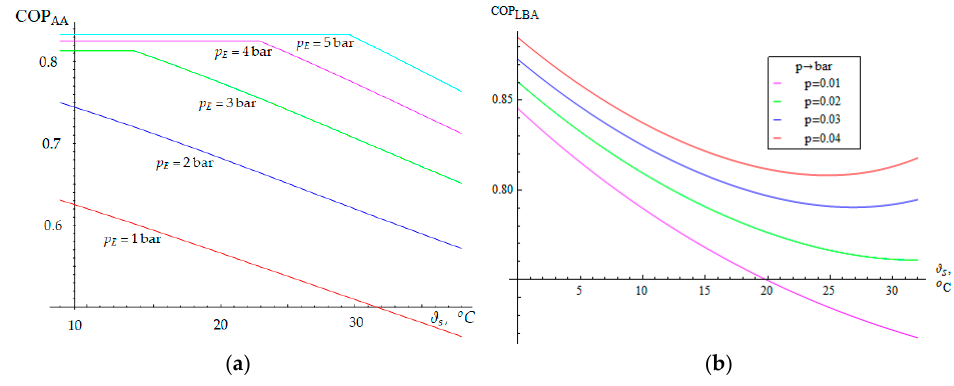
Figure 8. Quasi-static characteristics ( a ) COP AA ( p CE , ϑ cs ) and ( b ) COP LBA ( p CE , ϑ cs ) . Unsteady cooling effects corresponding to the occurring heat loads of AARU and LBARU evaporators are: